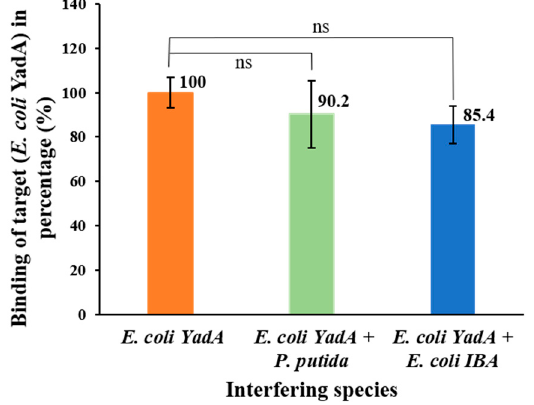
Figure 8. Selectivity behavior of the biosensor with Apt1 for E. coli YadA against P. putida and E. coli IBA after 30 min incubation and for the same redox probe previously tested. All bacterial strains were maintained at a concentration of 7.0 × 10 6 CFU mL − 1 . One-way ANOVA indicated that the differences between group means were not statistically significant and denoted ns for p > 0.05, the p value was 0.34.